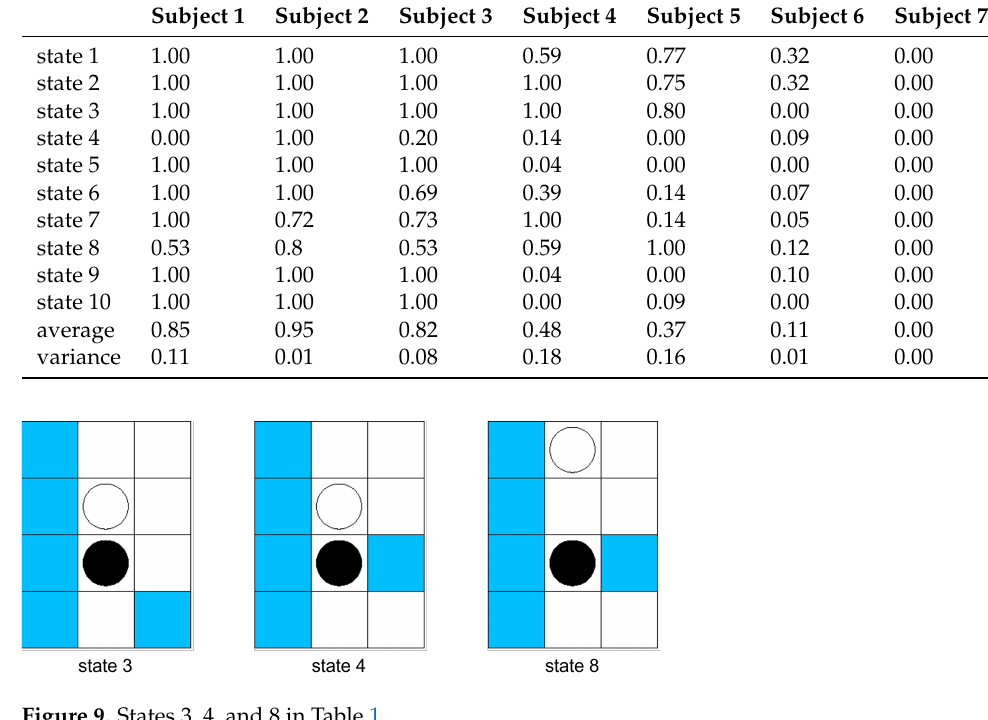
Figure 9. States 3, 4, and 8 in Table